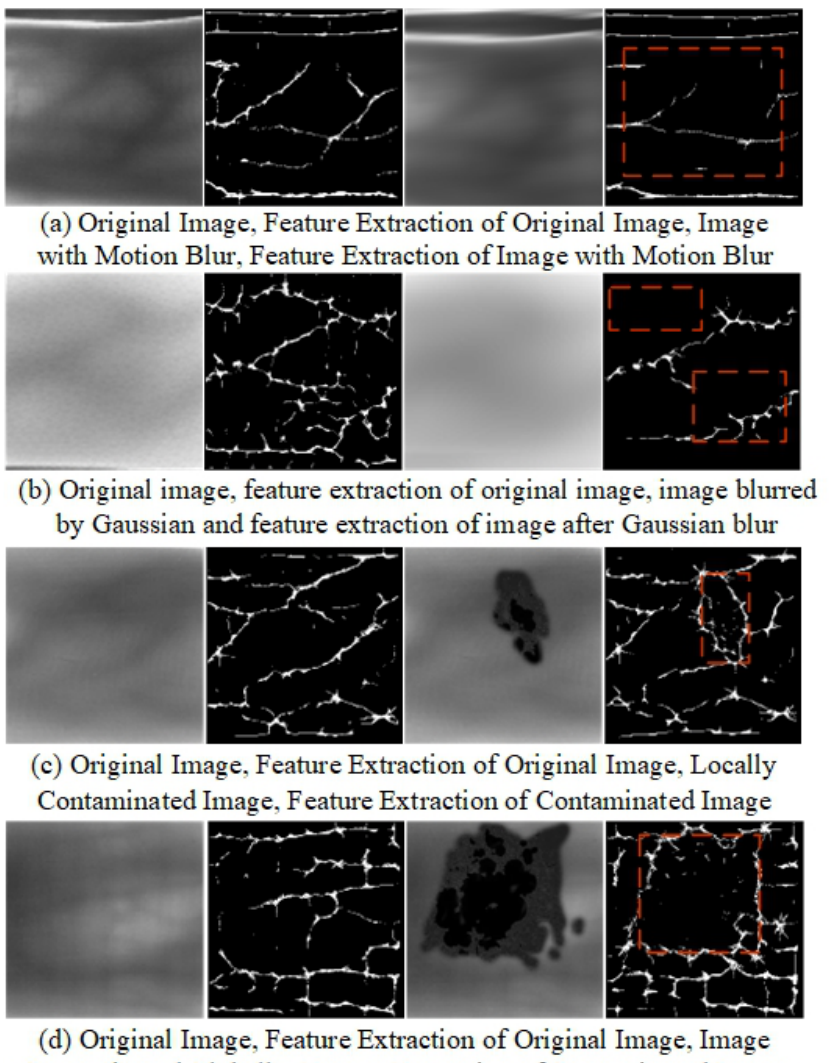
Figure 1. Low-quality finger vein images and images after feature